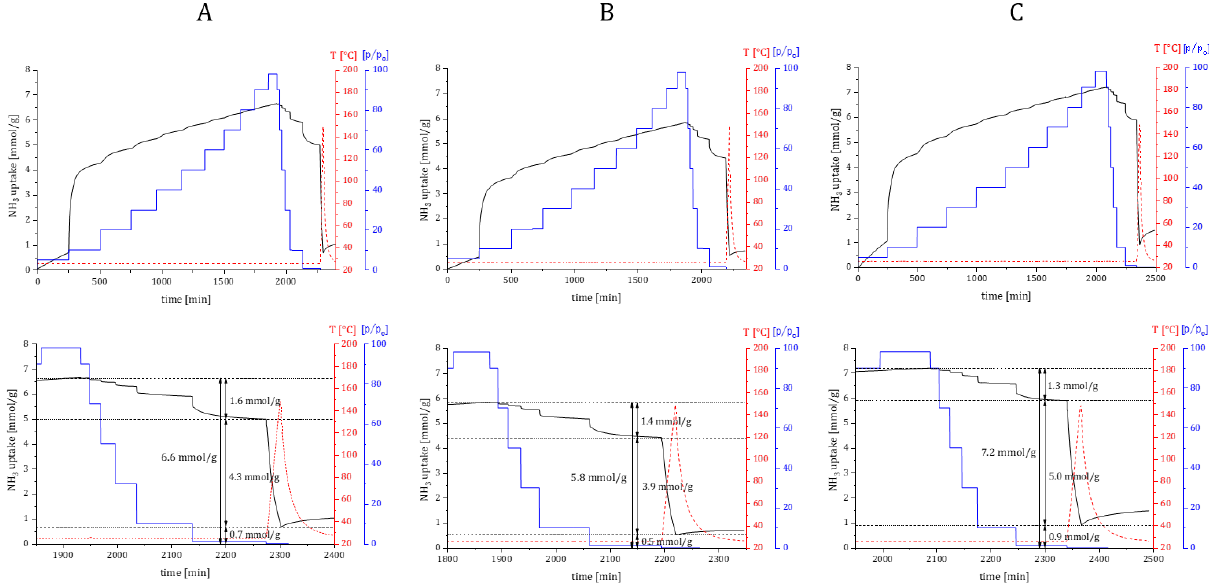
Figure 8. Ammonia sorption kinetics profile of selected materials (( A ) bioNICS1-MW-2h; ( B ) bioNICS1-FA-18-2h; ( C ) bioNICS1-PA-6-2h) and corresponding inserts (below) showing physiosorbed and chemisorbed fractions of adsorbed ammonia, together with remaining NH3 derivative species. Ammonia dosing pressure—blue line, heating temperature—red line. Unmodified bioNICS1 possess acid sites with a total amount of 4.3